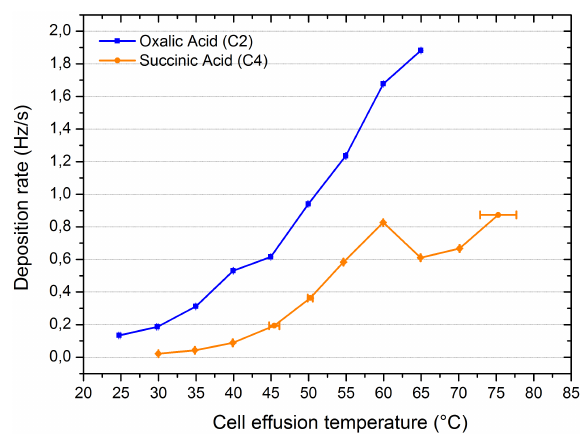
Figure 5. Blue curve: deposition rate curve of oxalic acid with tem- perature steps of 5 ◦ C, each lasting 30min. The deposition linearly increases with temperature, up to 60 ◦ C. Orange curve: deposition rate curve of succinic acid. The deposition rate increases with tem- perature up to 60 ◦ C, whereas at larger temperatures, it tends to os- cillate around an average value of 0.75Hzs − 1 , due to the steadiness of the sublimation